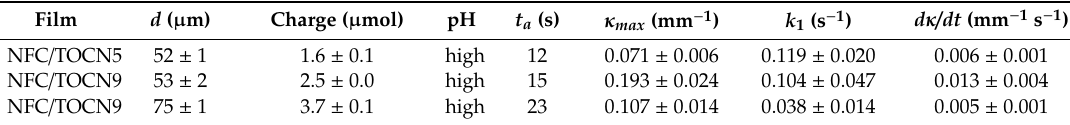
Table 2. Thickness ( d ), charge of the nanopaper, pH stimulus, actuation time ( t a ), maximum curvature ( κ max ), actuation rate constant ( k 1 ), and actuation rate ( d κ / dt ) for the NFC / TOCN